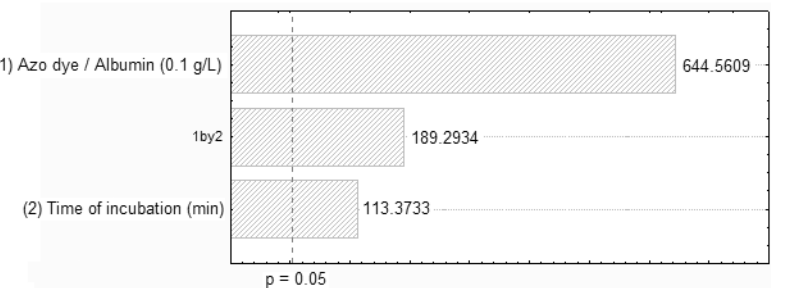
Figure 1. Pareto chart of standardized effects of removing Orange II related to azo dye/albumin (0.1 g/L) concentrations and time of